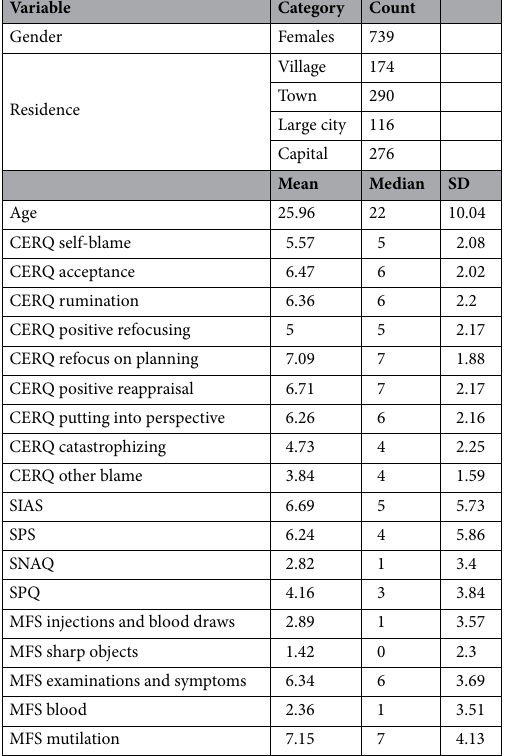
Table 1. Detailed descriptive statistics of the sample including demographic variables and the questionnaires used in the study. CERQ Cognitive Emotion Regulation Scale, SIAS Social Interaction Anxiety Scale,